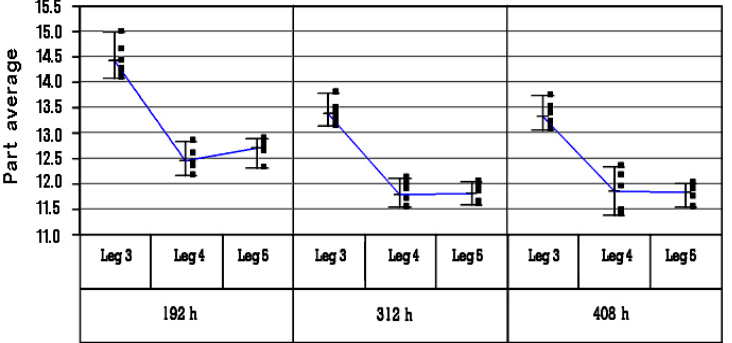
Figure 20. Variability chart for part average.